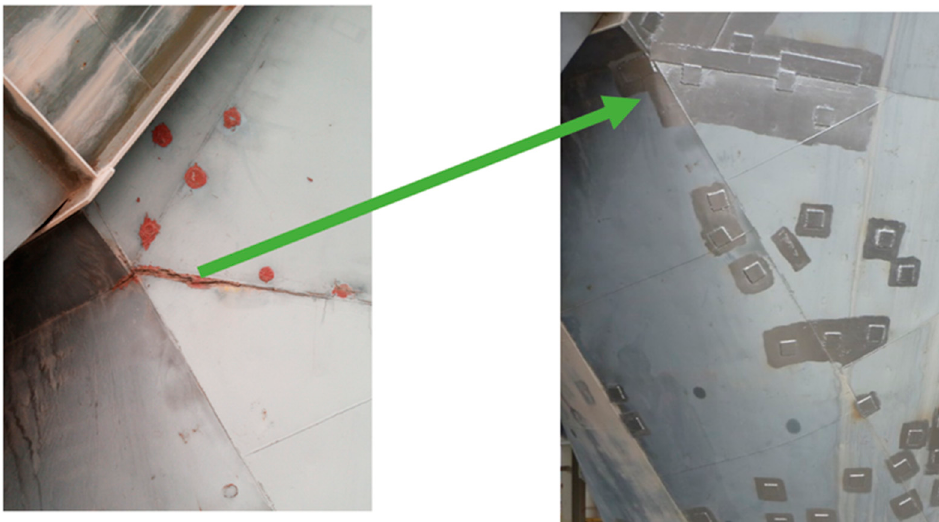
Figure 9. View of the structure before ( left side ) and after the repairs ( right side ).